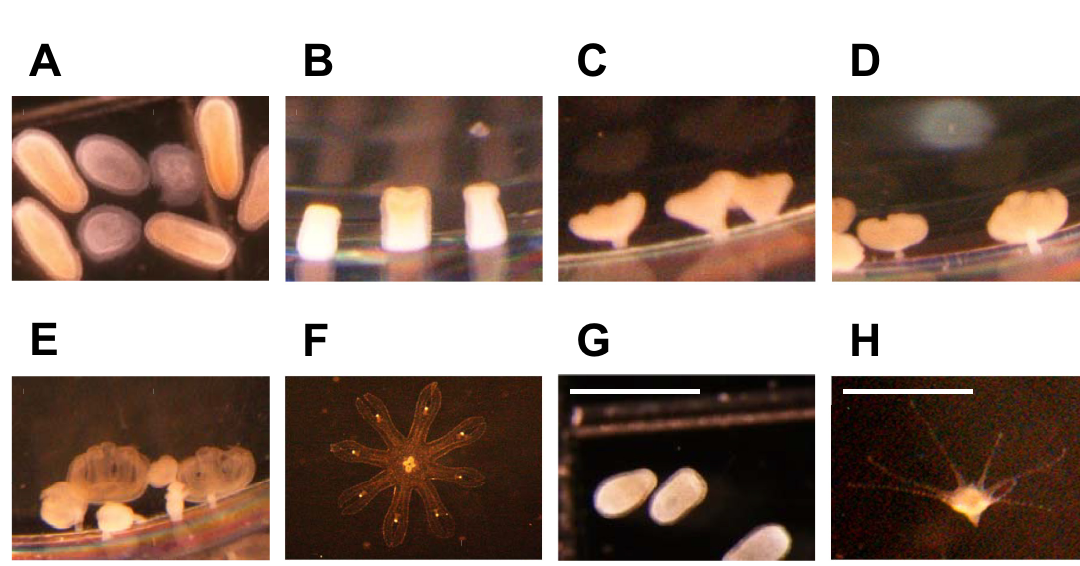
Fig 4. Two types of ontogenetic development of planulae in Maizuru Bay. Transformation process of the direct-development type from planula (A) to ephyra (F). The images B–F were taken 2, 6, 10, 12, and 15 days after the onset of incubation at 10˚C, respectively. Transformation process of the metagenetic type from planula (G) to polyp (H). The image H was taken 7 days after the onset of incubation at 28˚C. In B–E and H, A . coerulea attached to the wall of 24-well plates located in the lower part of the pictures. The scale bars indicate 1 mm.